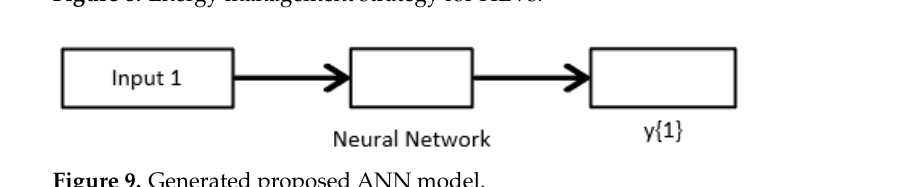
Figure 8. Energy management strategy for HEVs.